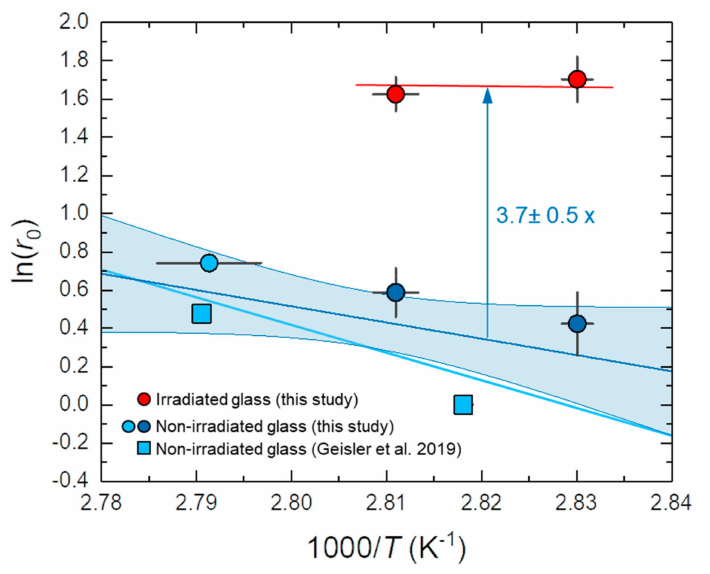
Figure 6. Arrhenius diagram with the initial or forward dissolution rates r 0 obtained for the non-irradiated (blue symbols) and irradiated (red symbols) TBG. Data from Geisler et al. [21] are also plotted. The dark and light blue lines represent an unweighted and an error-weighted linear fit to the data, respectively. For the unweighted fit the 1-sigma confidence interval is also shown as we use this fit to estimate r 0irr / r 0 and its